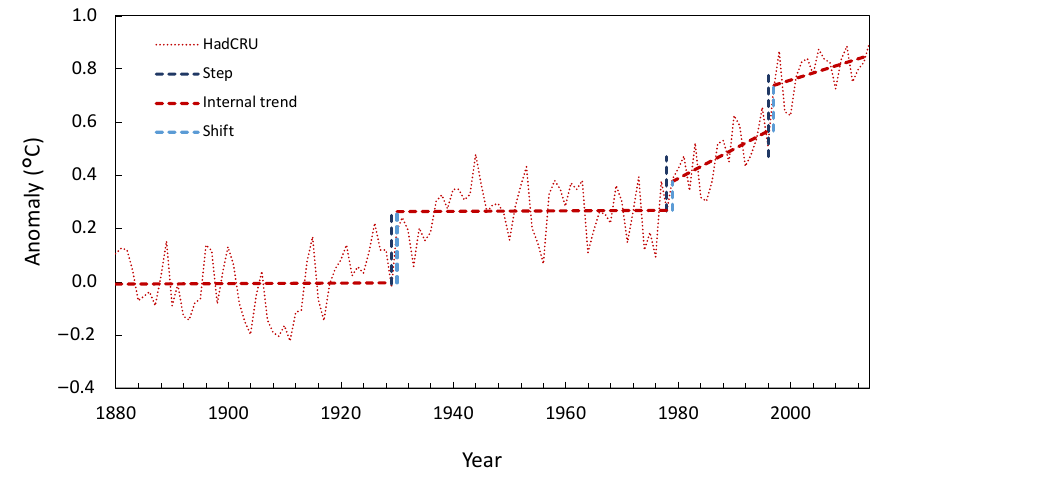
Figure 1. Record of mean annual surface temperature anomalies 1880–2014 from the Hadley Centre and Climate Research Unit (HadCRU), showing step changes ( p <0.01) and internal trends and shifts taken from the end of one internal trend to the start of the next across a